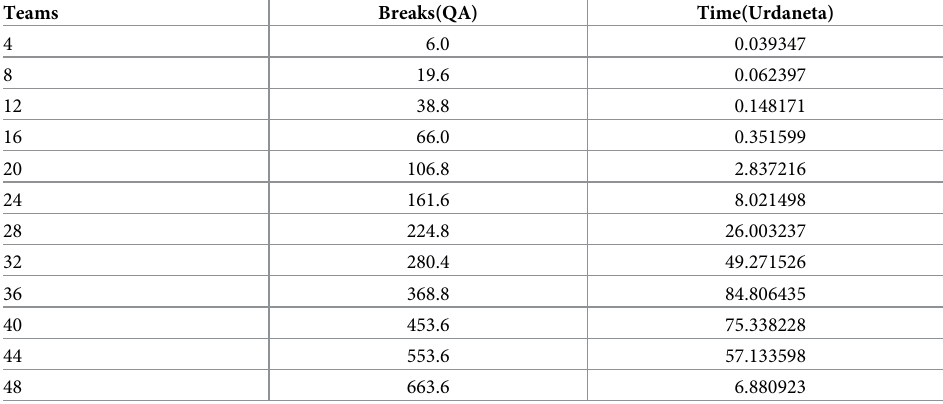
Table 8. QA vs. IP(Urdaneta) in MDRRTs.